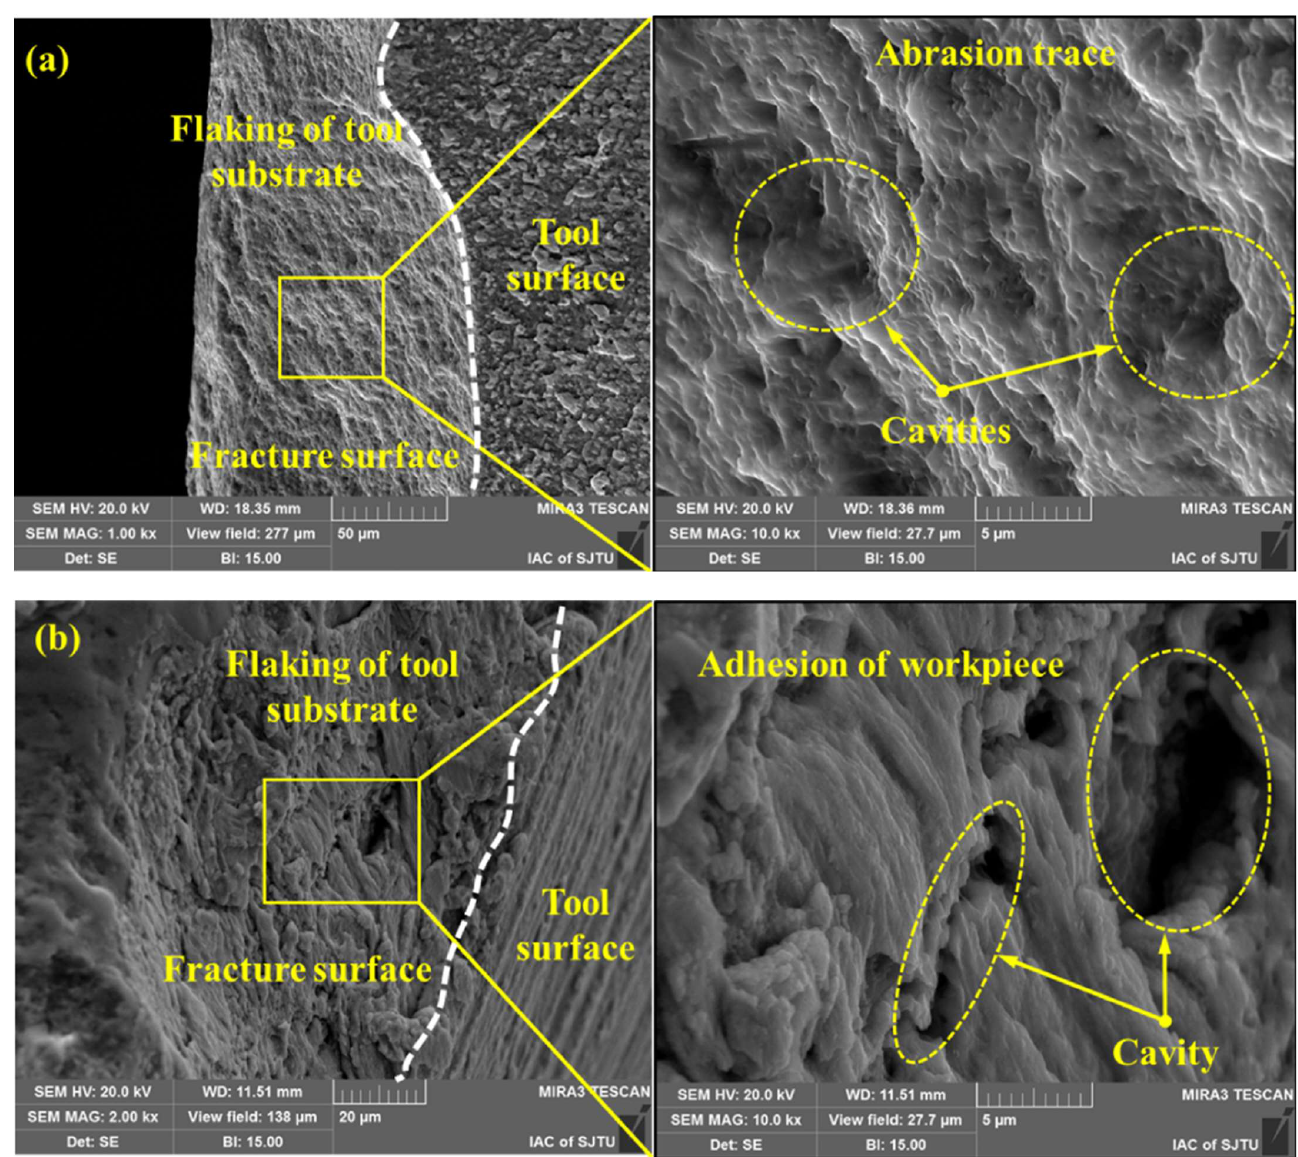
Figure 11. Wear types: ( a ) abrasion marks and ( b ) workpiece adhesion [125] (Reprinted with permission from [125]. Copyright 2020, Elsevier).